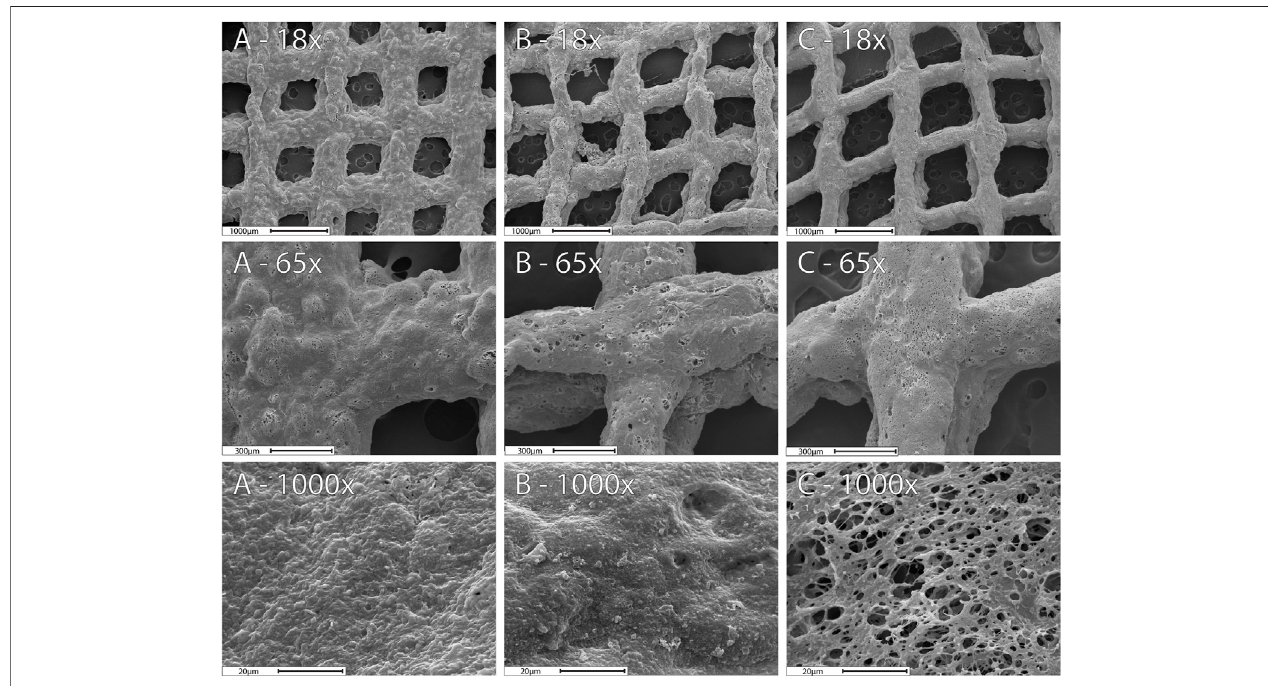
FIGURE 5 | SEM images for the 3D-Mesh previous release (A) , Mesh-Viol and Mesh-Viol-Lip released in phosphate buffer (pH = 7.4) after 24 h incubation (B) and (C) respectively.